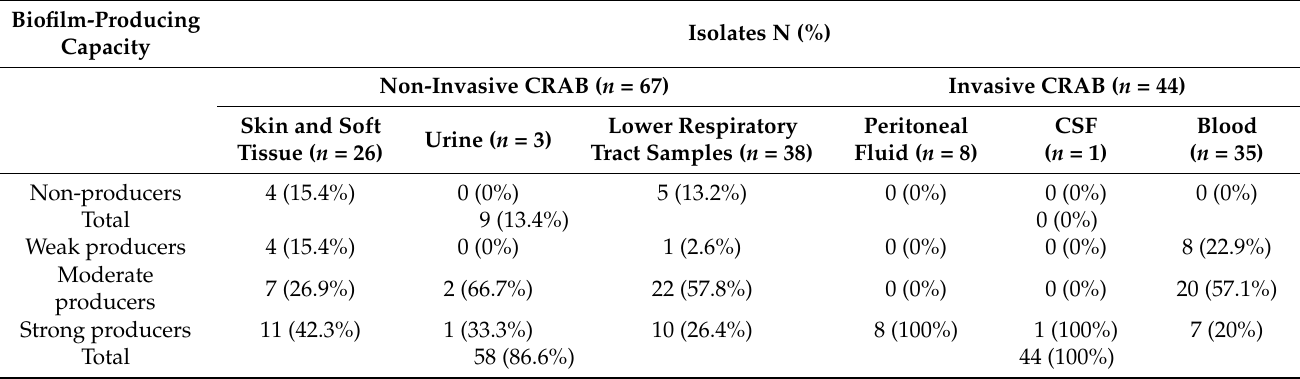
Table 1. Biofilm-production capacities among 111 invasive and non-invasive carbapenem-resistant Acinetobacter baumannii (CRAB) isolates obtained from various clinical